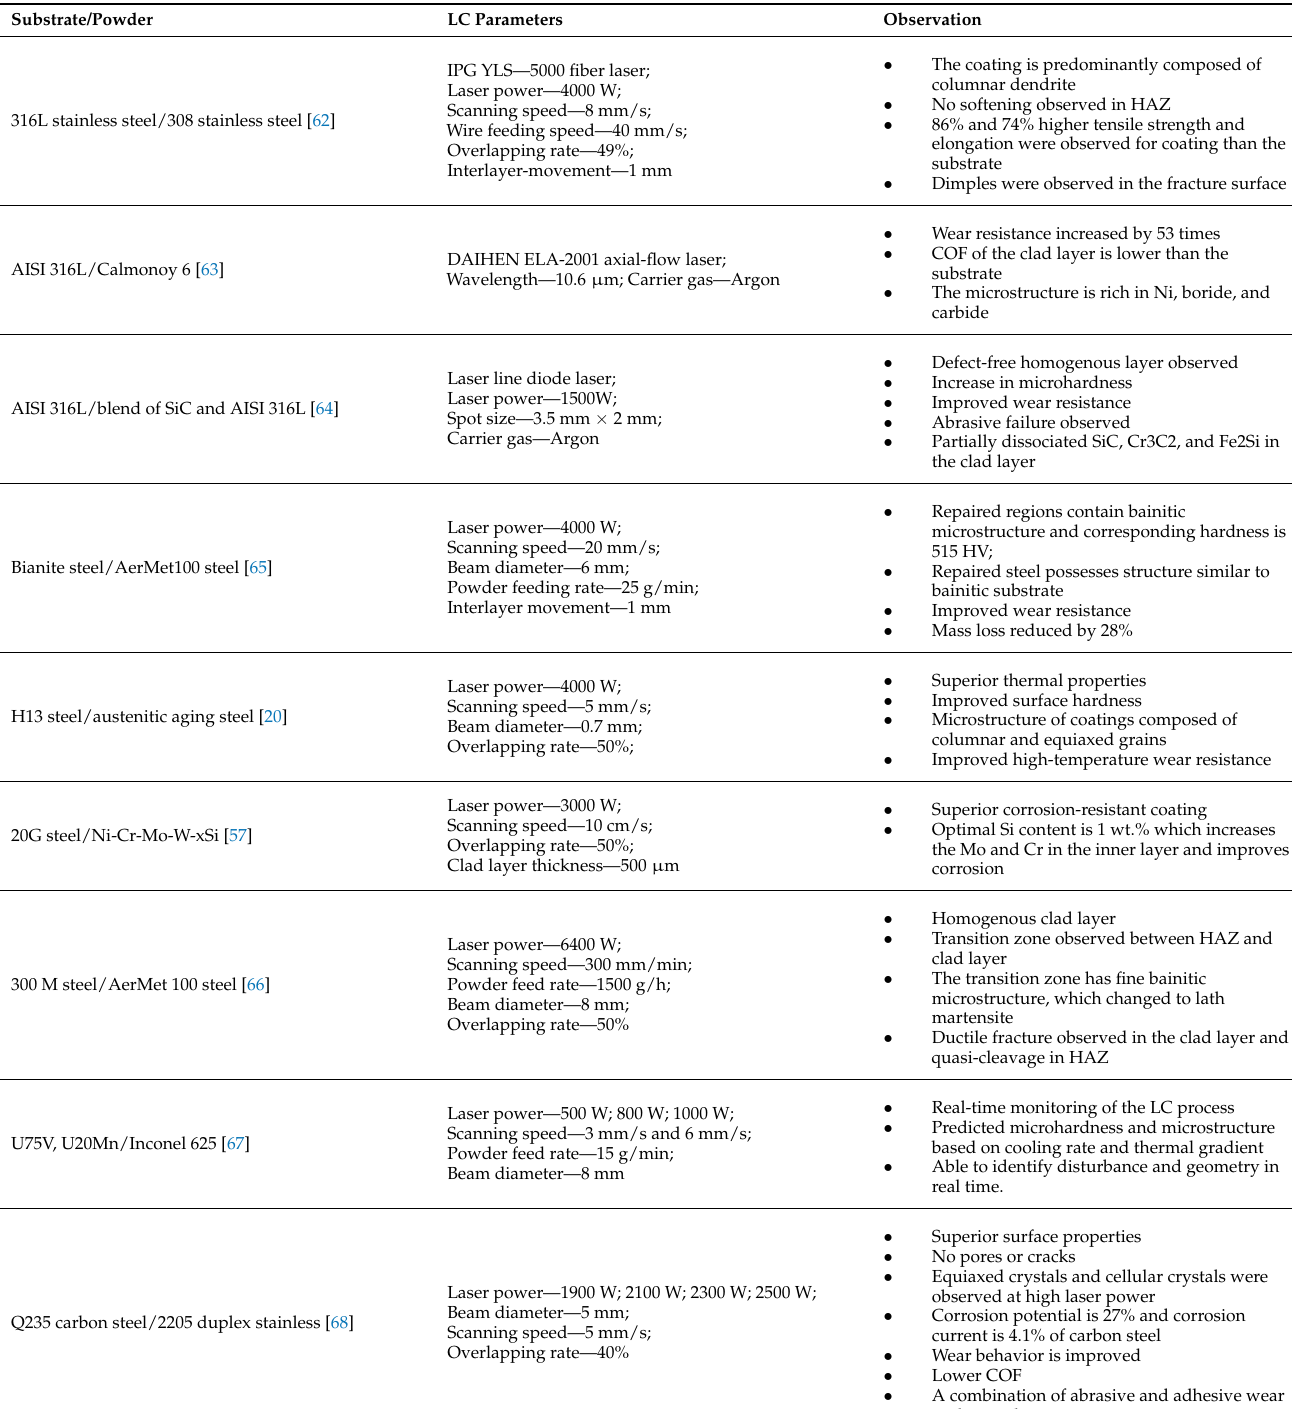
Table 1. LC process on low-carbon and high-alloy